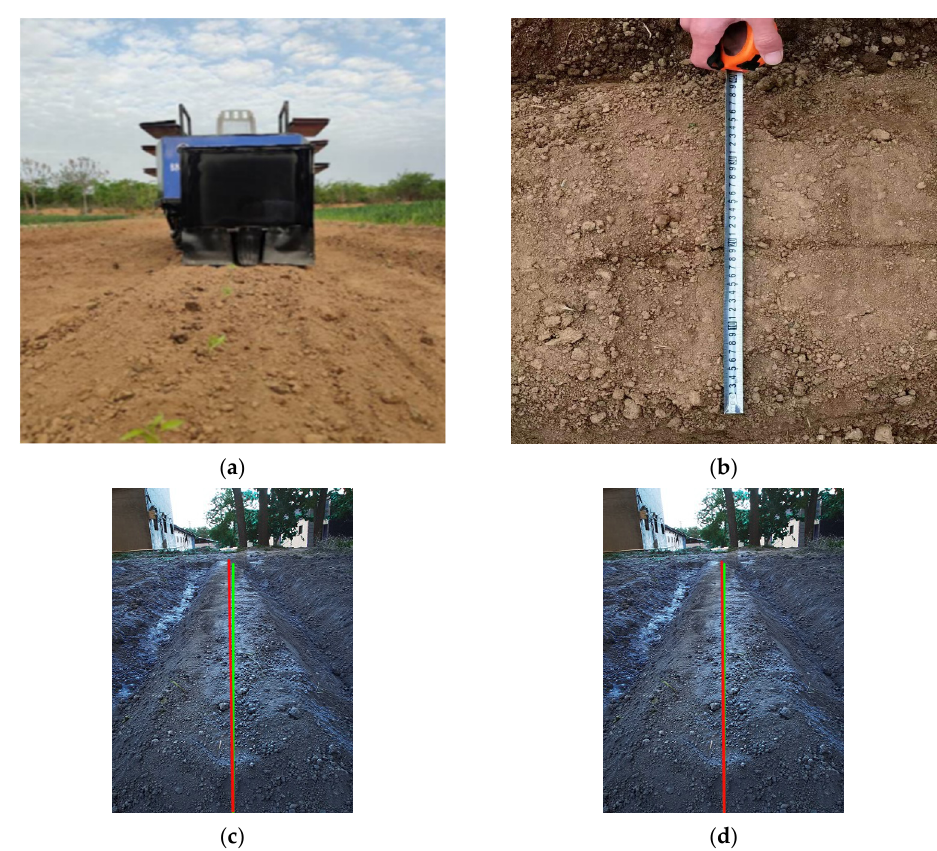
Figure 9. Controlled experiment. ( a ) Field experiments. ( b ) Field measurements. ( c ) Experimental Group 1. ( d ) Experimental Group 2.